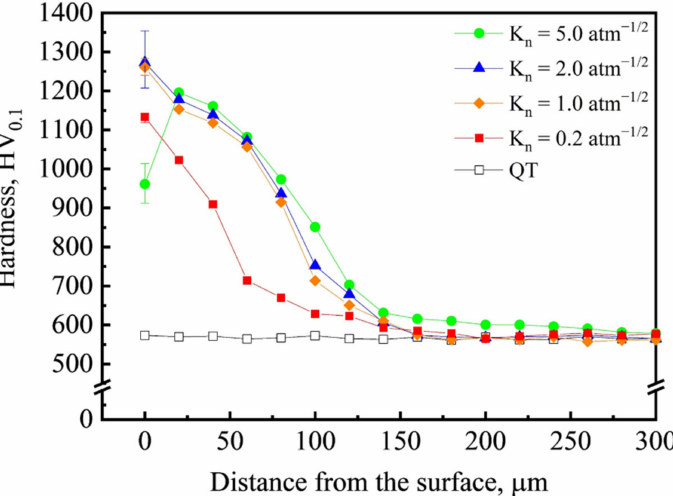
Figure 2. Hardness profiles of the QT and nitrided specimens as a function of distance from the top surface.